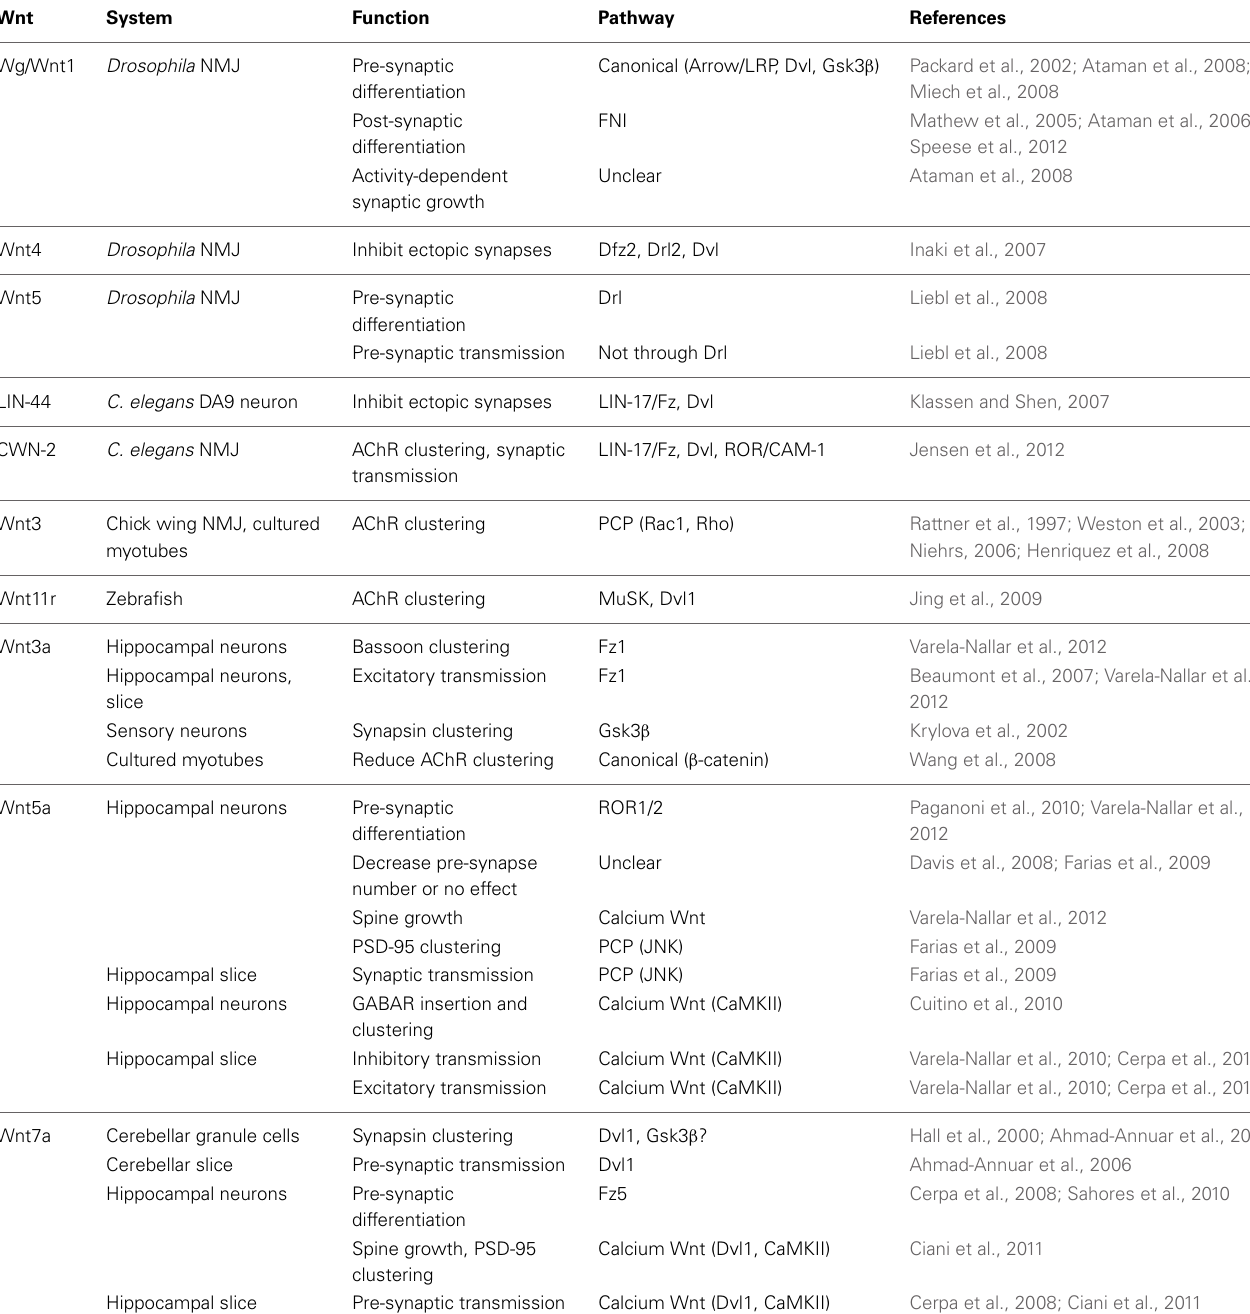
Table 1 | Known functions of Wnts in synaptogenesis and synaptic